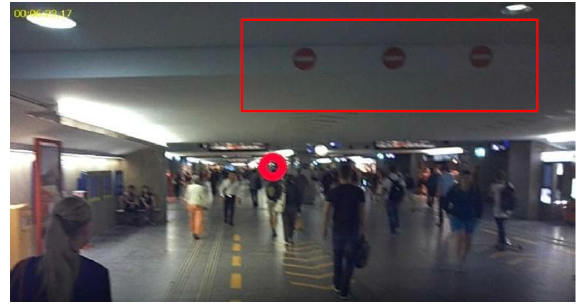
Figure 5. For most of the participants, the one-way street signaling on the ceiling is not in their visual